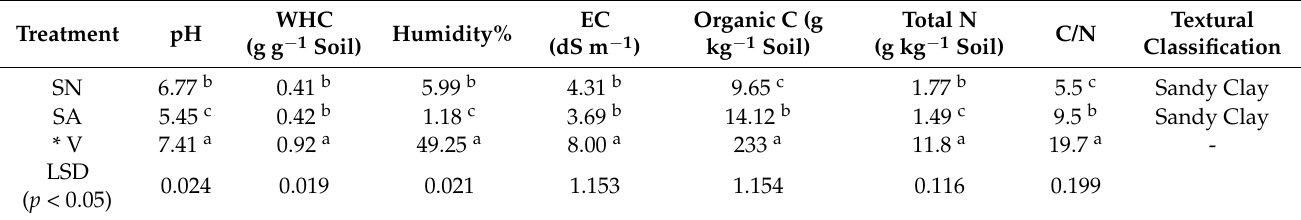
Table 1. Physicochemical characterization of soils and vermicompost.